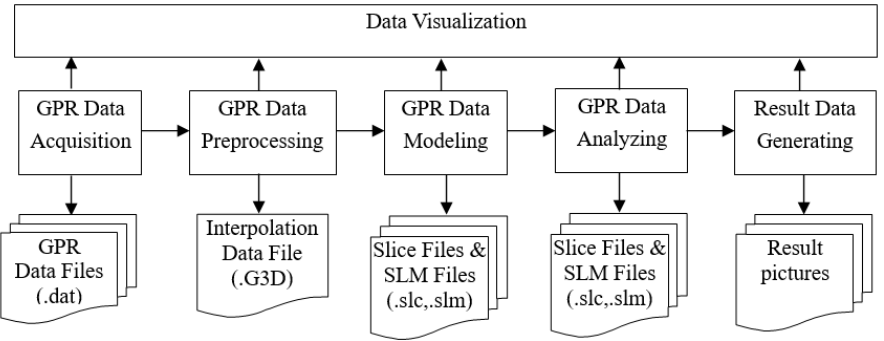
Figure 3. The workflow of 3DVF4UDR.